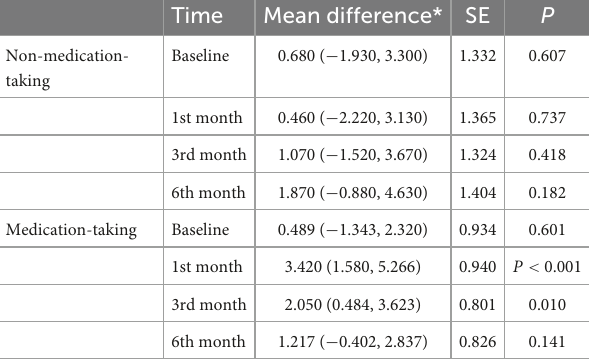
TABLE 5 Simple effect analysis of intervention factor.